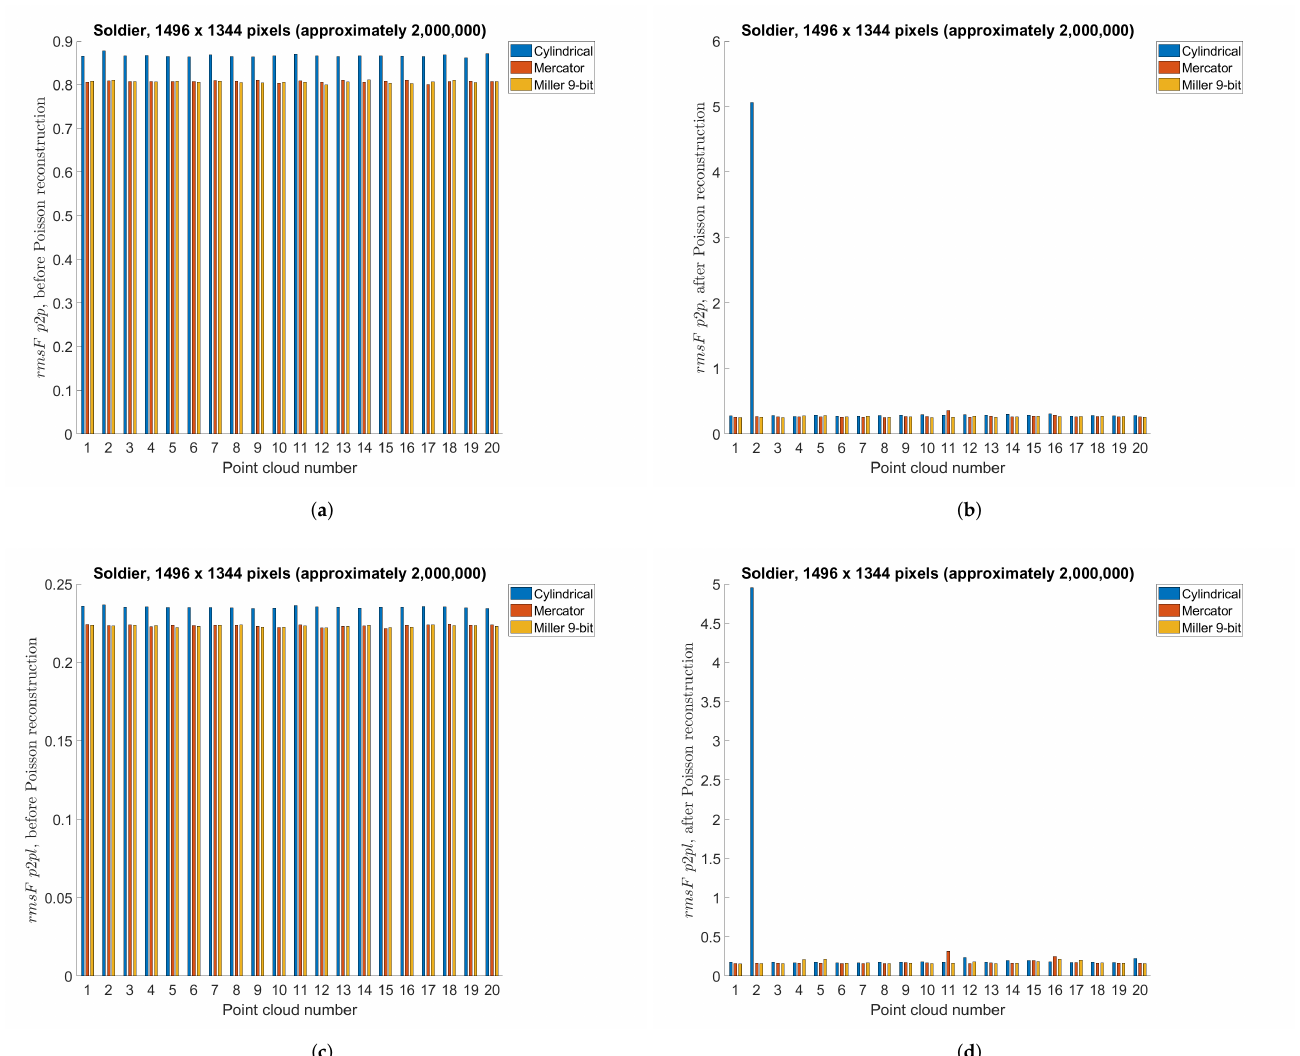
Figure 19. Point-to-point objective measure ( rmsF p2p ) per Soldier point cloud, using cylindrical, Mercator and Miller 9-bit depth projections with approximately 2,000,000 points: ( a ) point-to-point, before Poisson reconstruction; ( b ) point-to-point, after Poisson reconstruction; ( c ) point-to-plane, before Poisson reconstruction; ( d ) point-to-plane, after Poisson